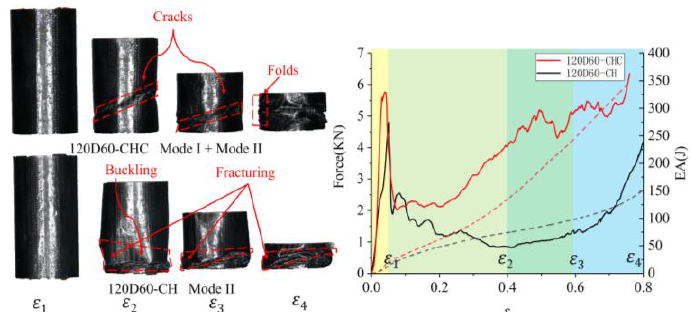
Figure 11. Failure mode and force – displacement curve of 120D60-CHC and 120D60-CH.